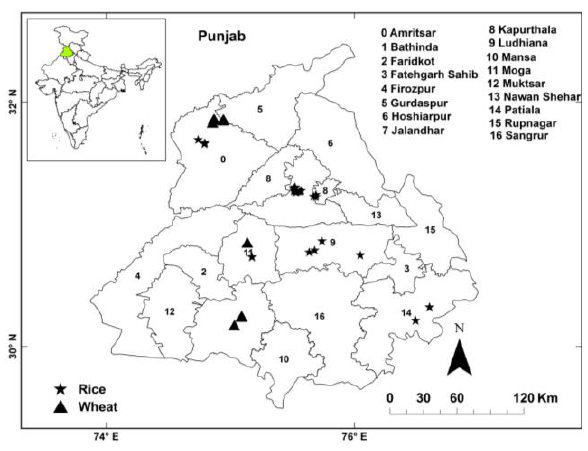
Figure 1. Field locations of fuel load measurement during rice and wheat harvesting season in Punjab plain (North-West India).